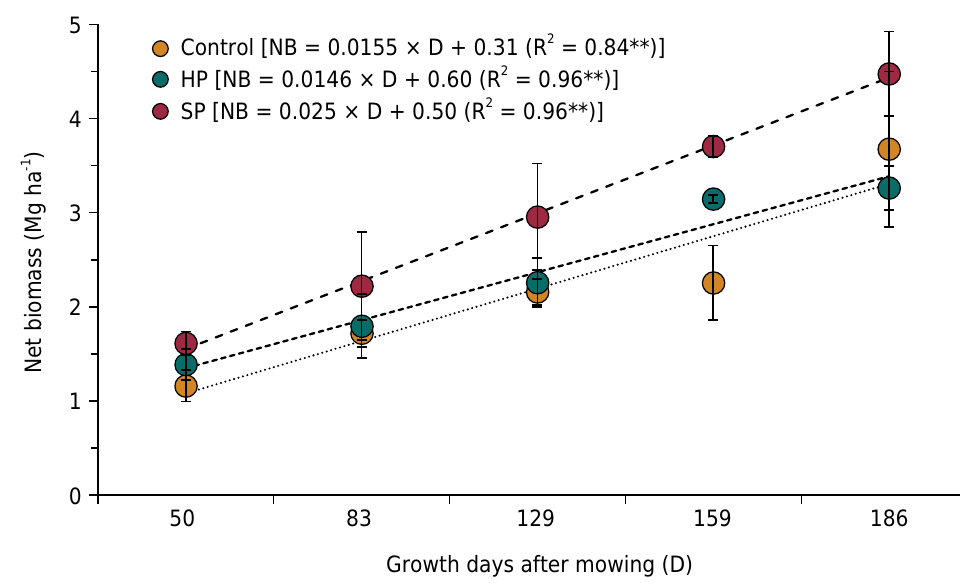
Figure 2. Net biomass (NB) over time in a natural grassland, from Southern Brazil, with the application of different P sources. Control: without P addition; HP: hyperphosphate; SP: